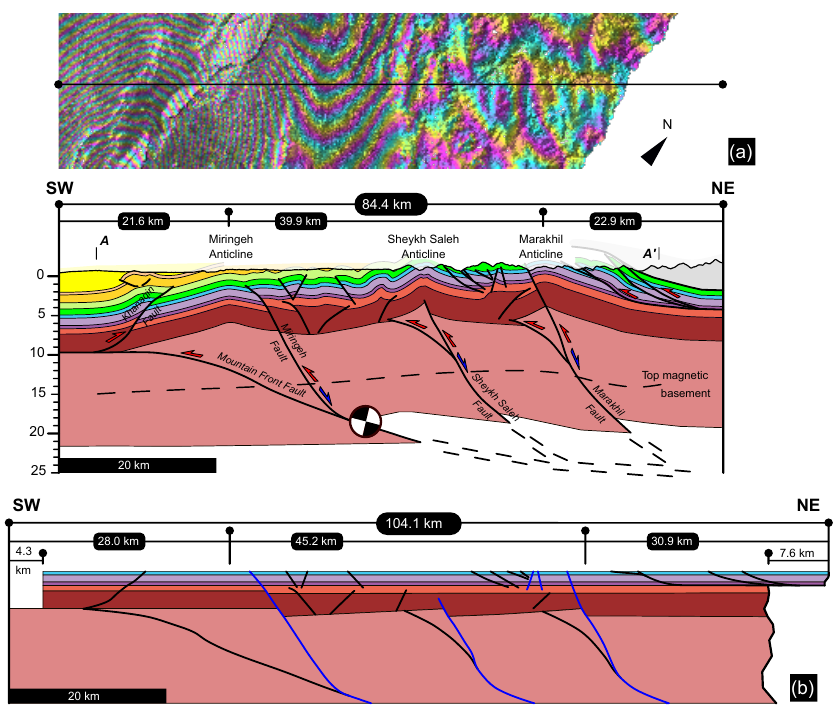
Figure 6. (a) Balanced cross section along the direction of the geological section in Figs. 4 and 5, showing projected main shock and detail of the co-seismic interferogram with a trace of the section. (b) Restored